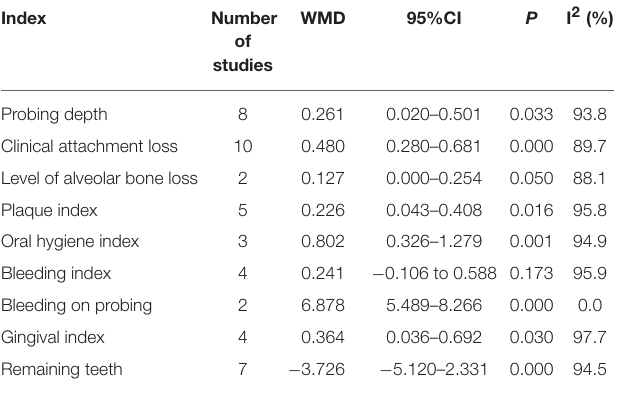
Frontiers in Physiology |